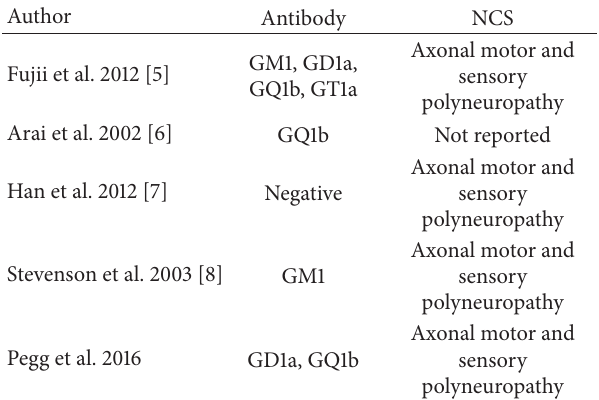
Table 1: Reported cases of overlapping